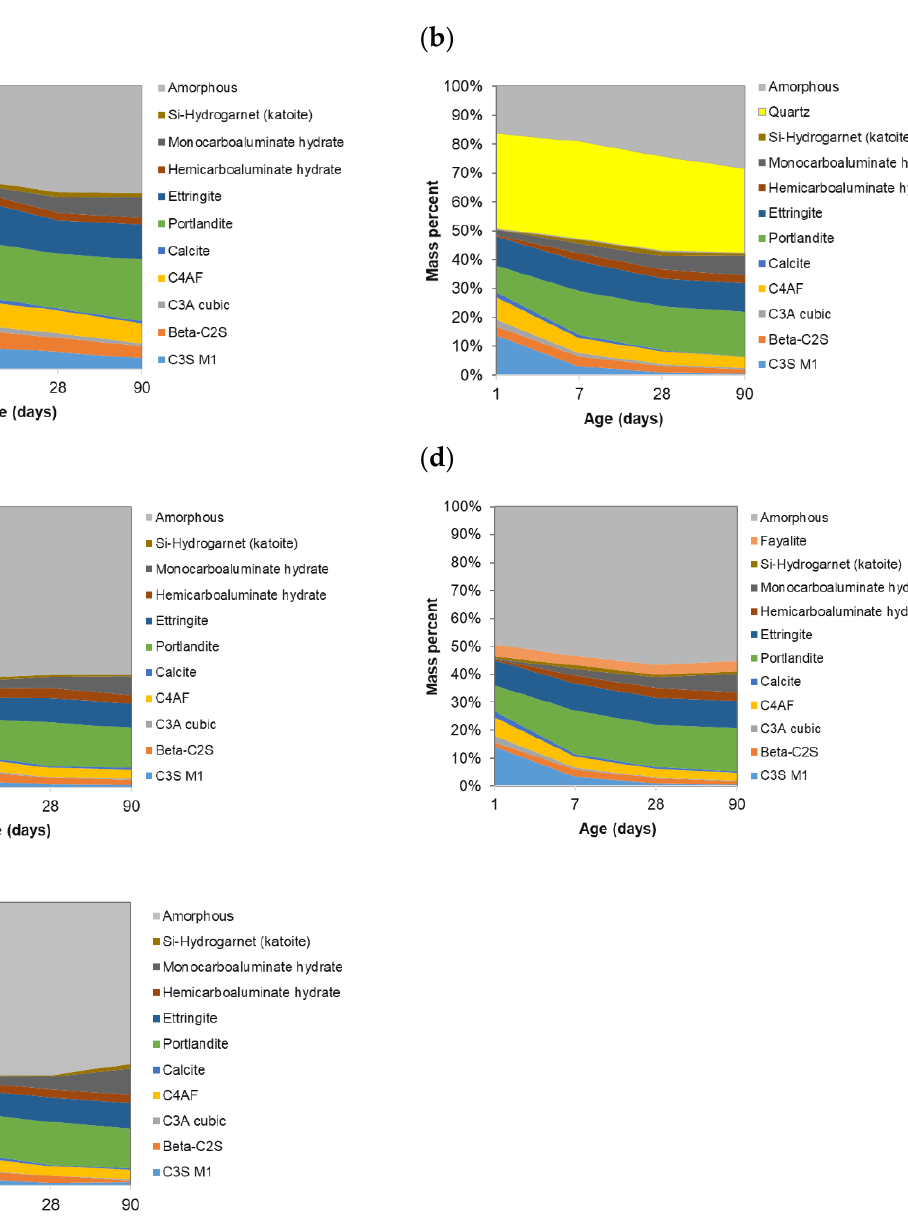
Figure 5. The evolution of X-ray patterns of different pastes over time: ( a ) P_PC, ( b ) P_QP, ( c ) P_TS1, ( d ) P_TS2 and ( e ) P_TS3. Ett: ettringite; Hc: hemicarboaluminate hydrate; Mc: monocarboaluminate hydrate; Pt: portlandite; Ft: fayalite.